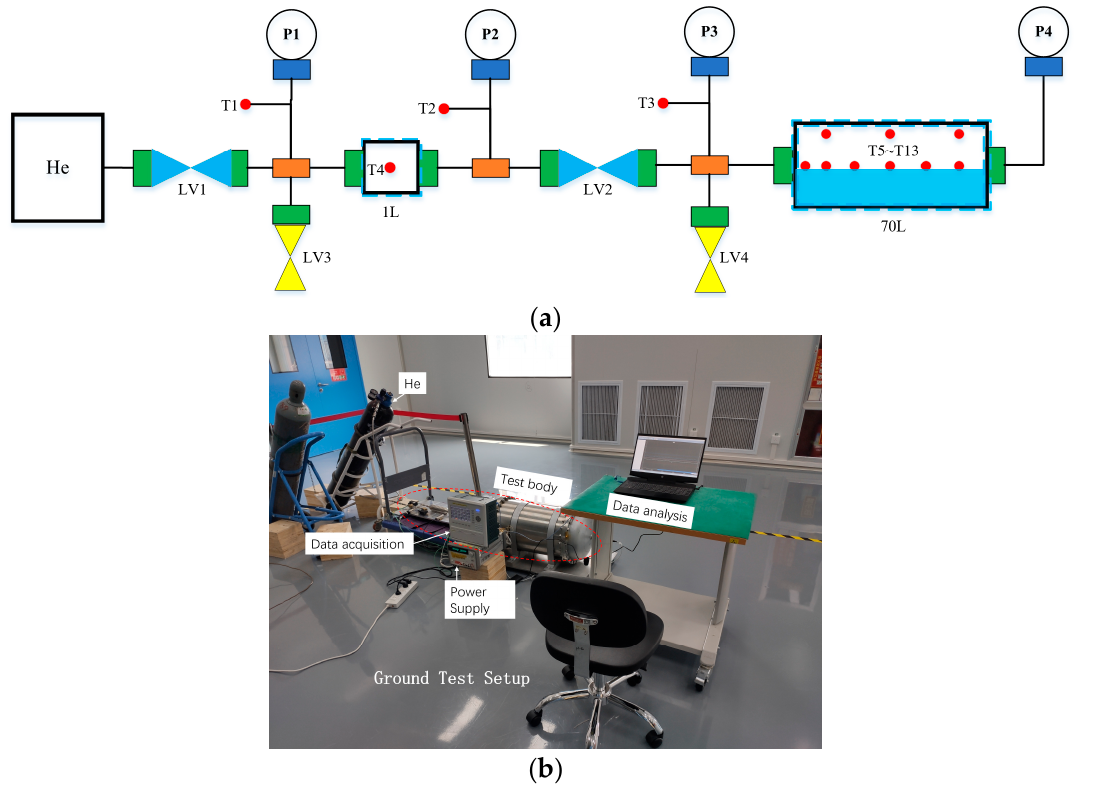
Figure 5. Experimental setup of the ground test (( a ) is the schematic, and ( b ) is the real setup). From Figure 5a,b, one can see the ground test setup. There is a helium gas source of approximately 13~15 MPa, an injection bottle of approximately 1 L, a propellant tank of approximately 70 L, some valves, and pressure and temperature sensors. The volume in the ground test is chosen to be small to reduce the danger as well as reduce the cost, which is approximately 10 times smaller than the theoretical model. LV1 and LV2 are valves used in the high pressure and LV2 and LV4 are valves used in the middle pressure. Temperature sensors T1 and T2 are set in the tube at the injection bottle inlet and outlet and T4 is inside the injection bottle to monitor the injection bottle temperature. Temperature sensors T3 and T5~T13 are installed in the tank inlet tube as well as on the shelf, which is built into the tank to monitor the inner gas temperature. All the test data are analyzed with a PC. When the gas injection test was conducted, the gas injected into the injection bottle and tank is released from LV3 and LV4, which will cause the pressure to be equal to the environment. It should be mentioned that the pressure sensors are selected with ultrahigh precision at 0.04% FS and the temperature sensors are selected with a precision of 0.4% FS, while its response time to the temperature change around is 0.1